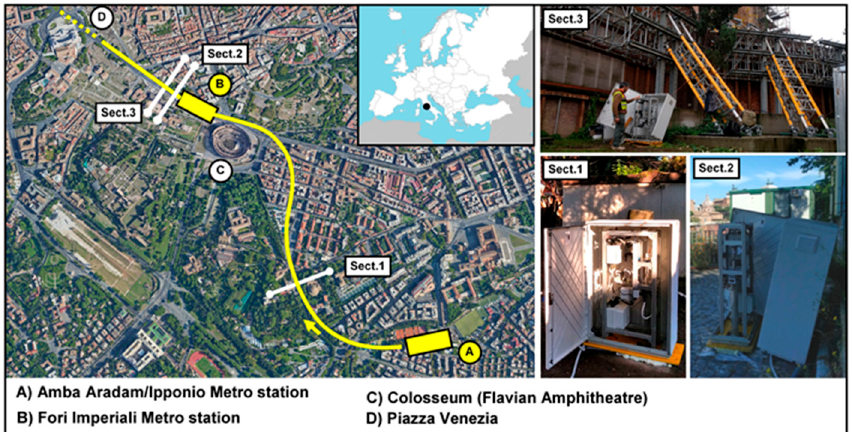
Figure 7. Location of test sites in Rome. Table 2. Main characteristic of the inclinometer tubes installed. The cumulative eccentricity was calculated on the top of the borehole and the incremental value is a mean for each depth (every 50 cm).